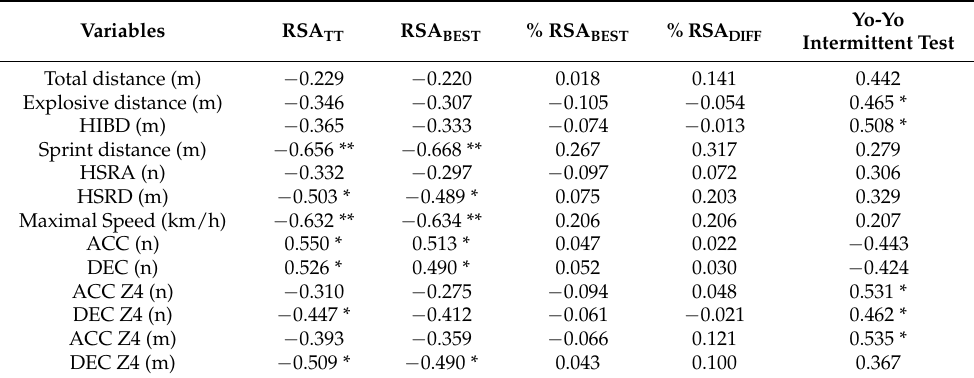
Table 3. Time speed in the RSA test and distance in Yo-Yo Intermittent Recovery Test Level 1 in female field referees’ fitness